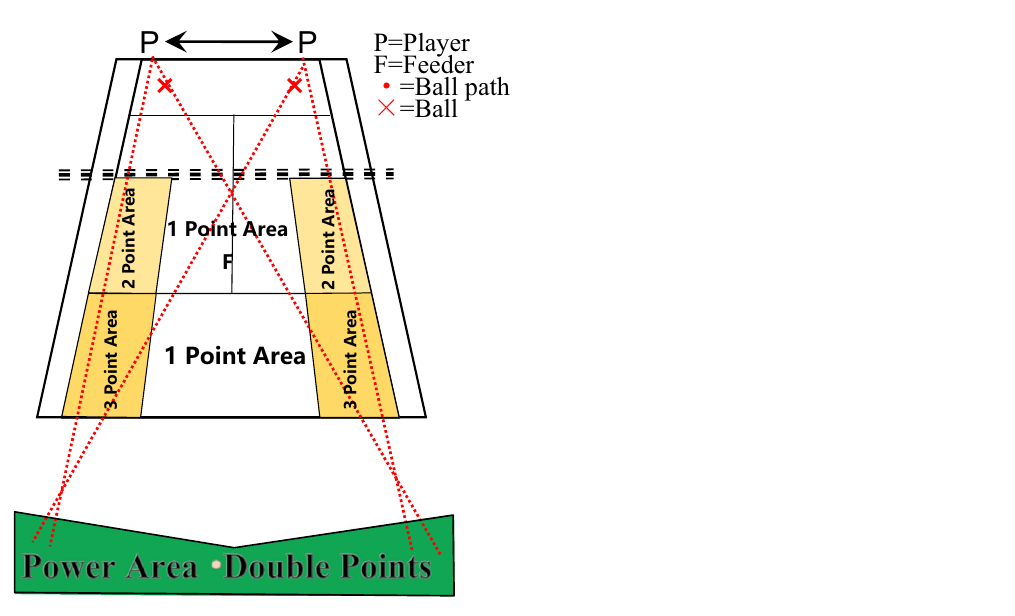
Figure 1. Hitting stability test (depth).